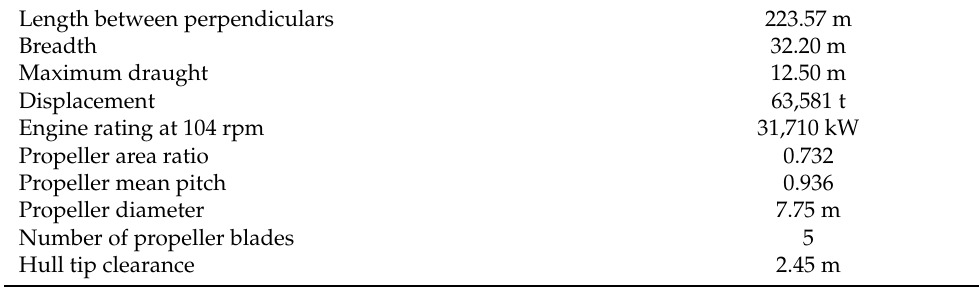
Figure 1. Mean signals of cavitation volume and corresponding sound pressure for one blade passage at 96.5 rpm calculated by the max − L method as reported in [13] from the total amount of isolated blade passages. Exemplary sequences are included as indicators for the overall variability. Table 1. Vessel characteristics.